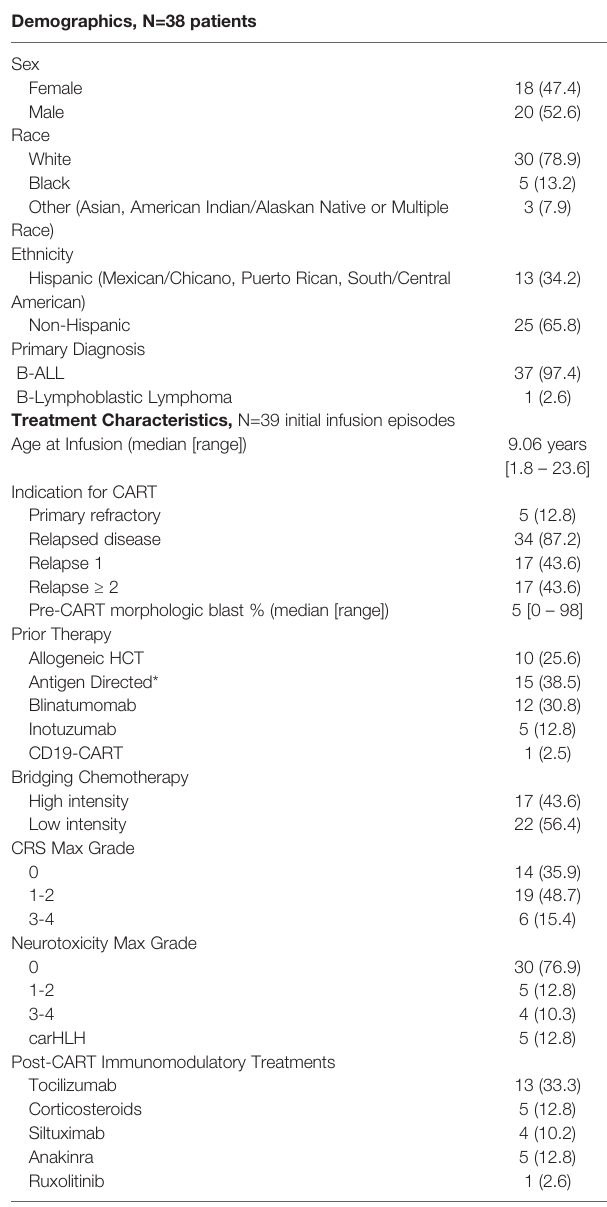
TABLE 1 | Demographics and treatment